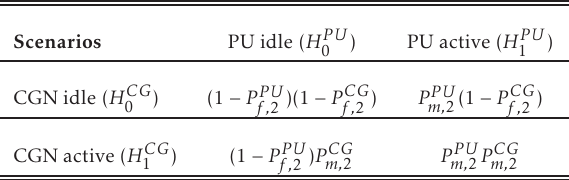
Table 2. Possible Transmission Probability for CRN under